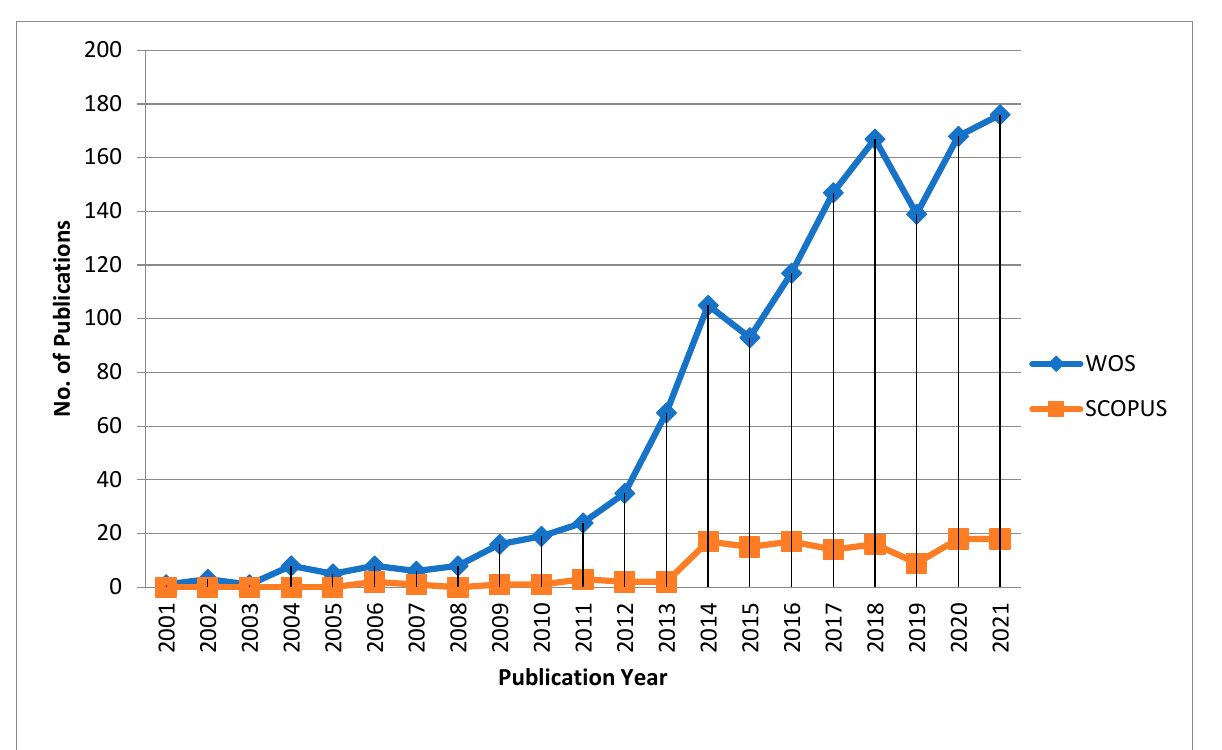
Figure 2. Total number of publications between 2000 to 2021 in SCOPUS and WOS databases.